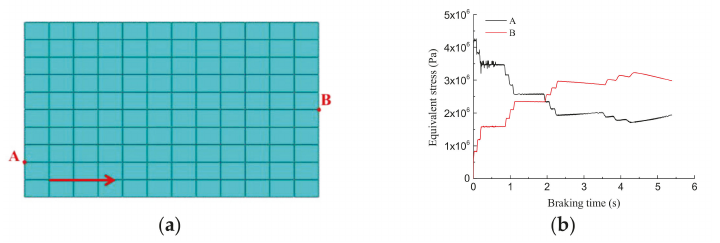
Figure 12. Evolution curves of equivalent stresses at both sides of brake shoe 6. ( a ) Selection of reference points. ( b ) Evolution curves of equivalent